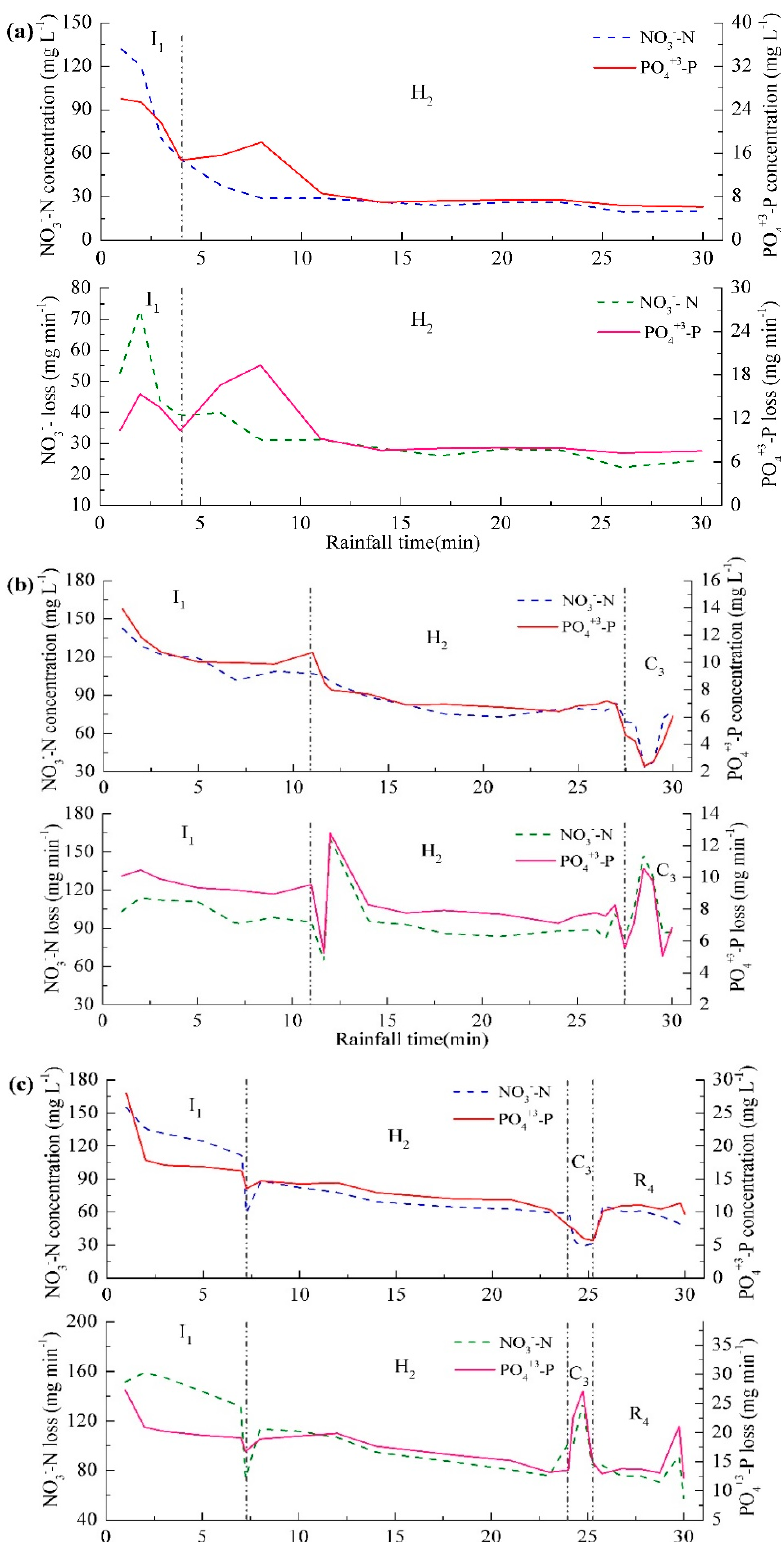
Figure 3. Soil surface morphology before and after rainfall experiments. ( a ) before rainfall; ( b ) in- ter-rill and headward erosion process; ( c ) contour failure; ( d ) rill erosion.